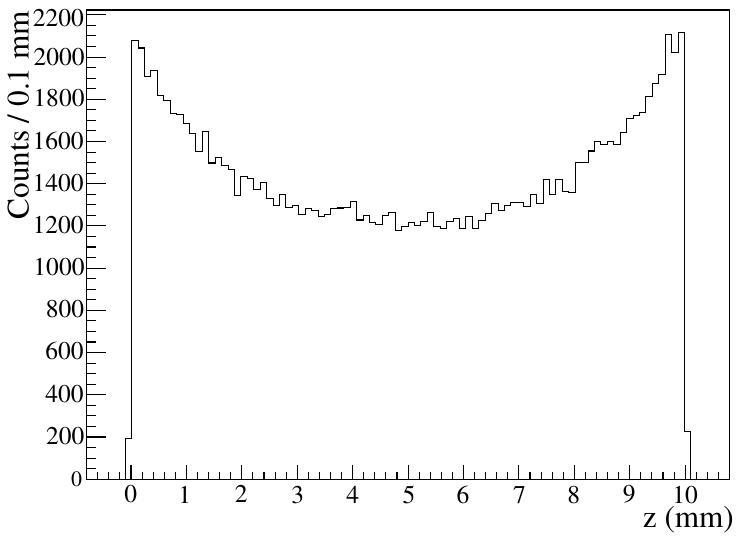
Figure 8 . Distribution of the distances of the neutron-capture sites from the Al (cid:12)lm evaluated by a Monte Carlo simulation in a 20 (cid:2) 20 (cid:2) 10 mm Li 2 MoO 4 detector (10 6 generated neutrons, 125468 neutron captures). The (cid:12)lm is located at z = 0. The neutron (cid:12)eld is supposed to be isotropic and mono-energetic with neutron energy of 25